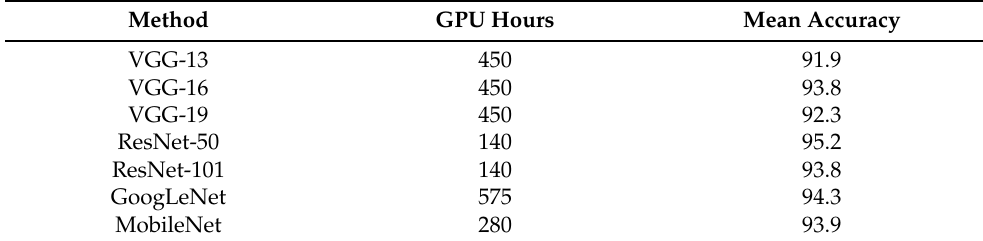
Table 3. Experiment results on different models.